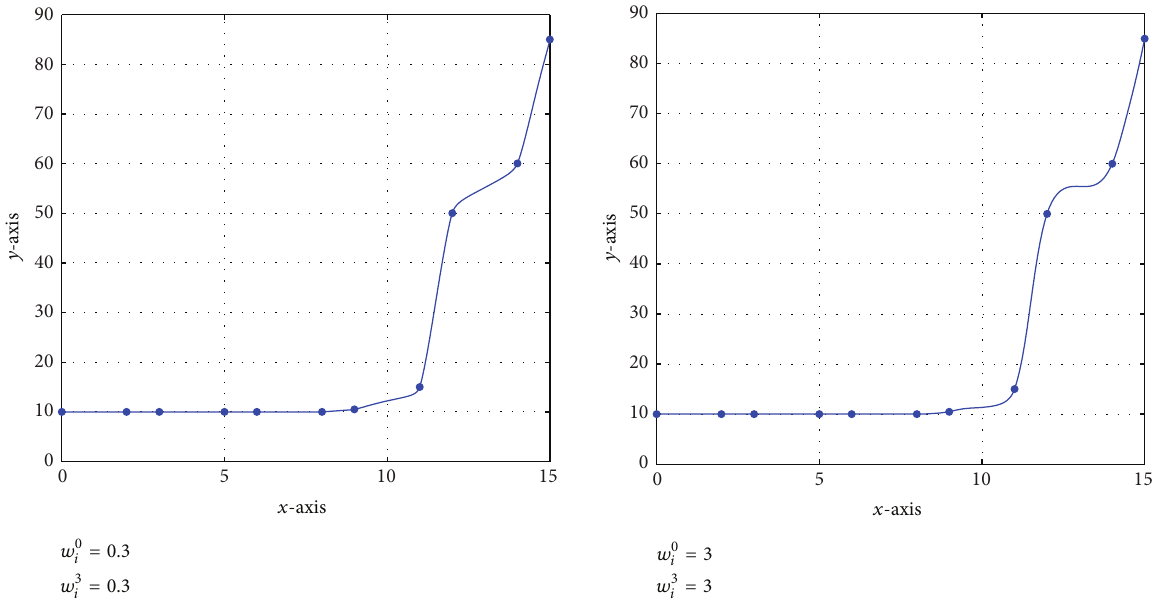
Figure 8: Monotone data visualization with specified values of free parameters.